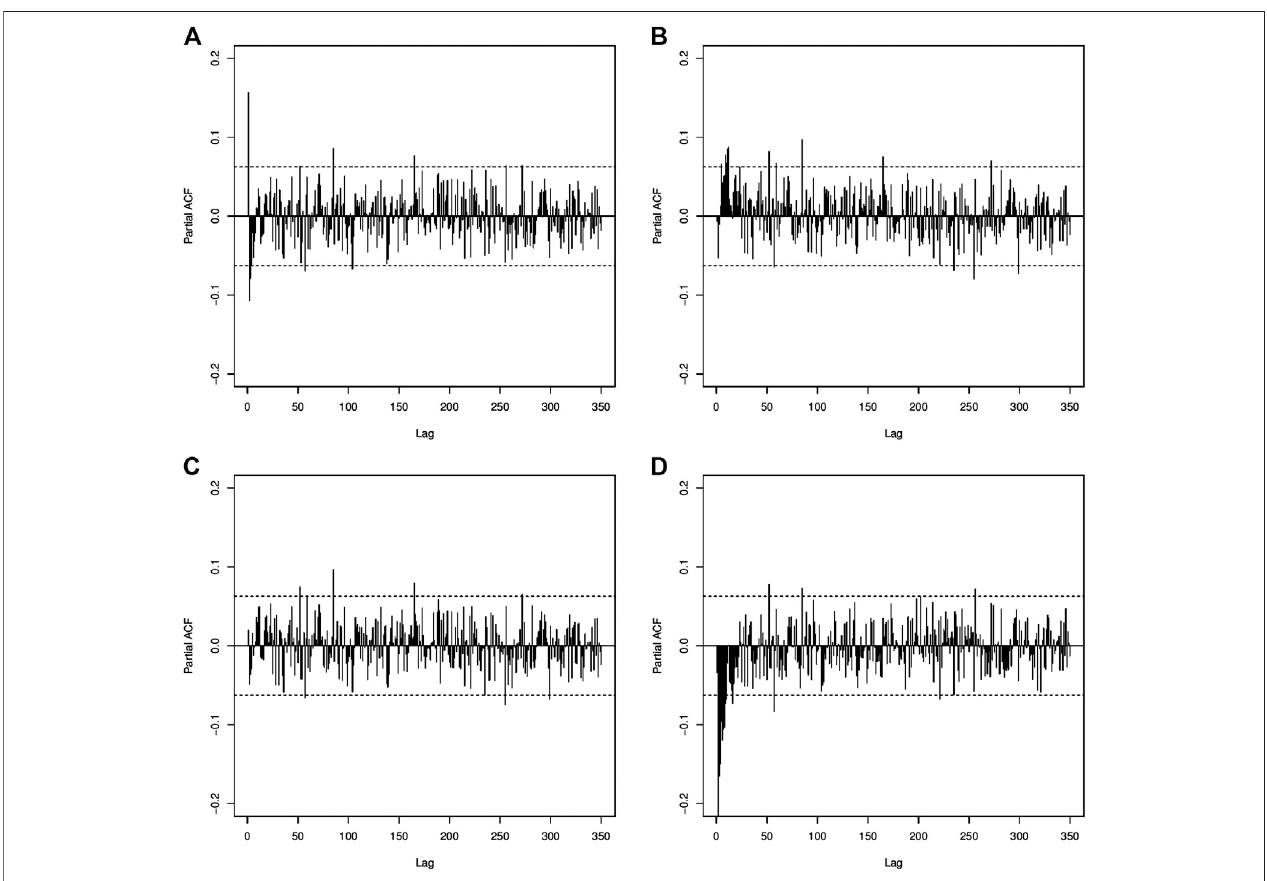
FIGURE 5 | Partial autocorrelation coef fi cients of the estimated Models (A – D) as labeled in Table 1 . The horizontal lines indicate the 95% con fi dence bounds for strict white noise.